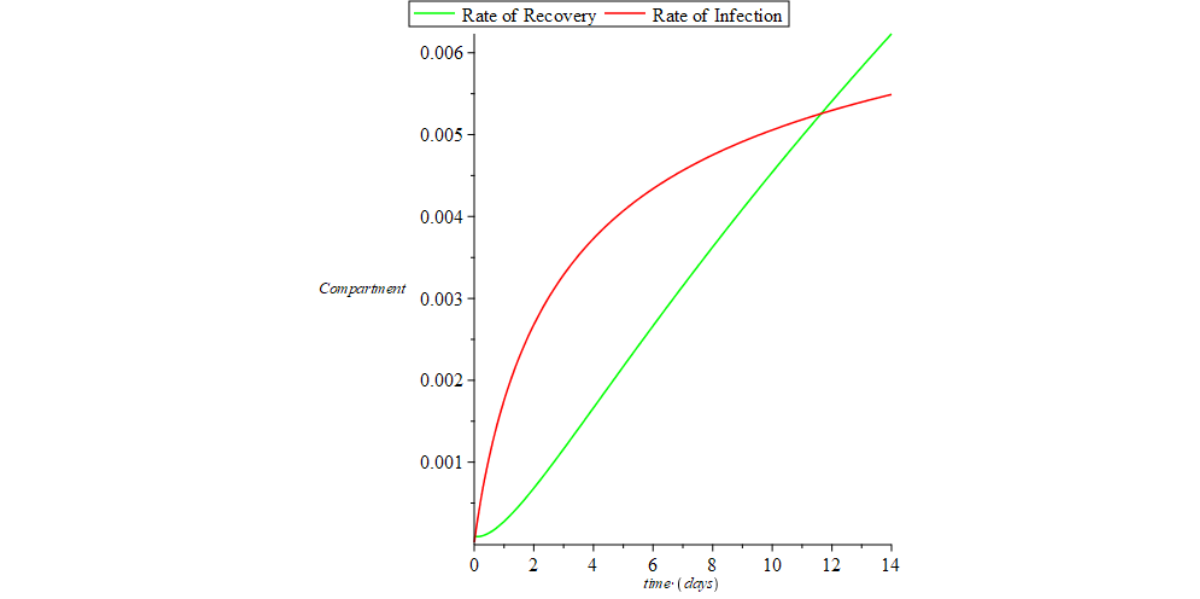
Figure 3. Chart of recovered and infectious compartments for coronavirus